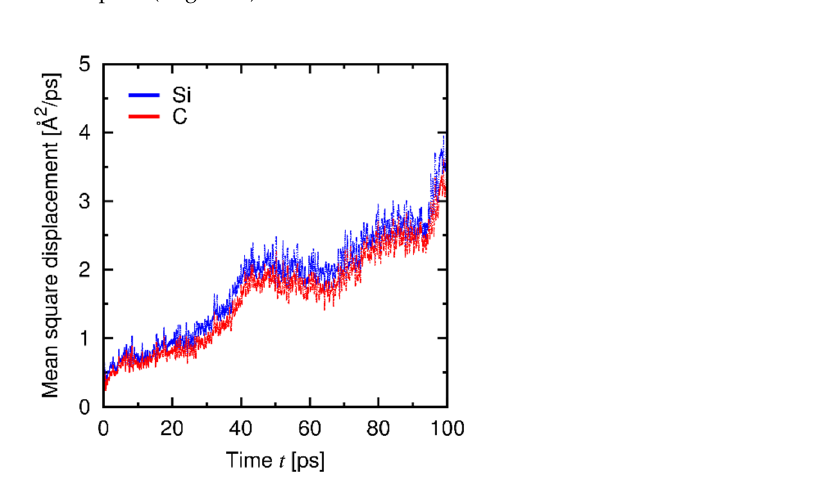
( a ) ( b ) ( a ) ( b ) ( a ) Figure 14. RDFs under d ε / dt -constant conditions for all contributions (Si-Si, Si-C, and C-C) at ( a ) d ε / dt = 2 × 10 − 3 ps − 1 (Region Figure 14. RDFs under d ε / dt -constant conditions for all contributions (Si-Si, Si-C, and C-C) at ( a ) d ε / dt = 2 × 10 − 3 ps − 1 (Region Figure 14. RDFs under d ε / dt -constant conditions for all contributions (Si-Si, Si-C, and C-C) at ( a ) d ε / dt = 2 × 10 − 3 ps − 1 Figure 14. RDFs under d ε / dt -constant conditions for all contributions (Si-Si, Si-C, and C-C) at ( a ) d ε / dt = 2 × 10 − 3 ps − 1 (Region I) and ( b ) d ε / dt = 2 × 10 − 1 ps − 1 (Region II) before and after deformation. I) and ( b ) d ε / dt = 2 × 10 − 1 ps − 1 (Region II) before and after deformation. (Region I) and ( b ) d ε / dt = 2 × 10 − 1 ps − 1 (Region II) before and after deformation. I) and ( b ) d ε / dt = 2 × 10 − 1 ps − 1 (Region II) before and after deformation.